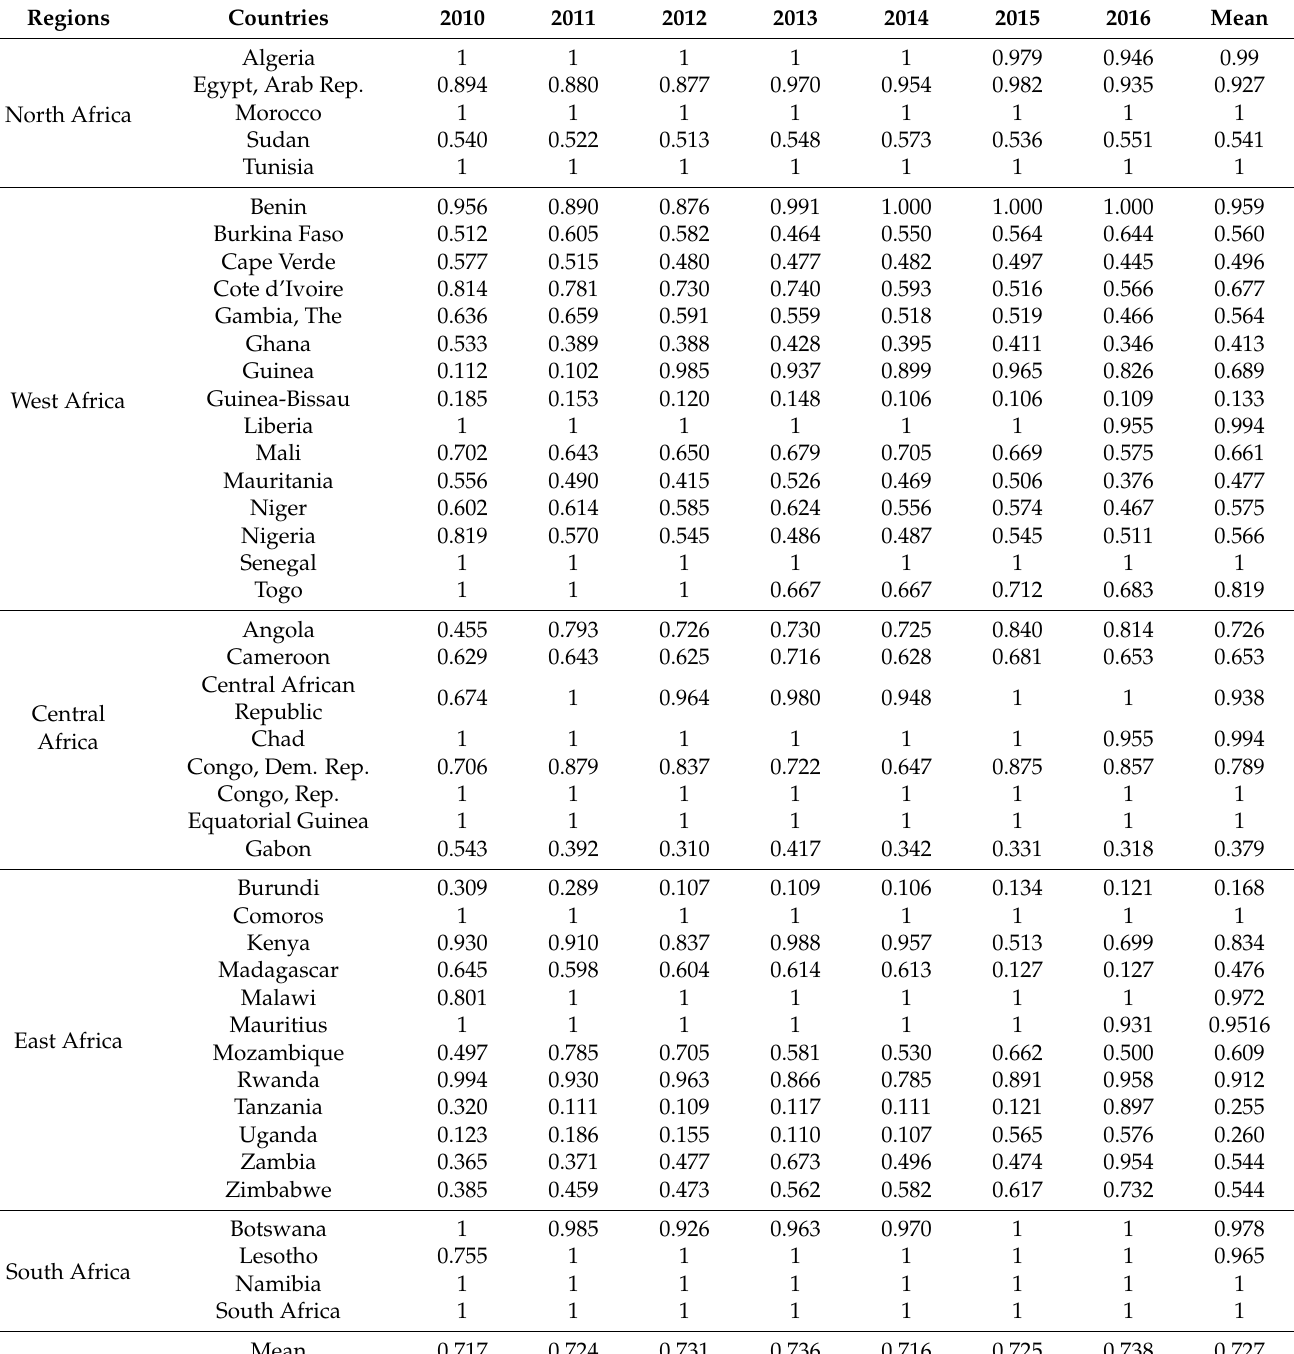
Table 6. GMDSTFEE in Africa from 2010 to